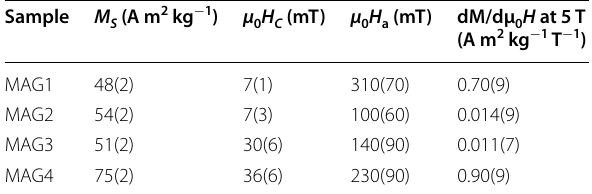
Table 2 Saturation magnetization ( M anisotropy field (µ 5